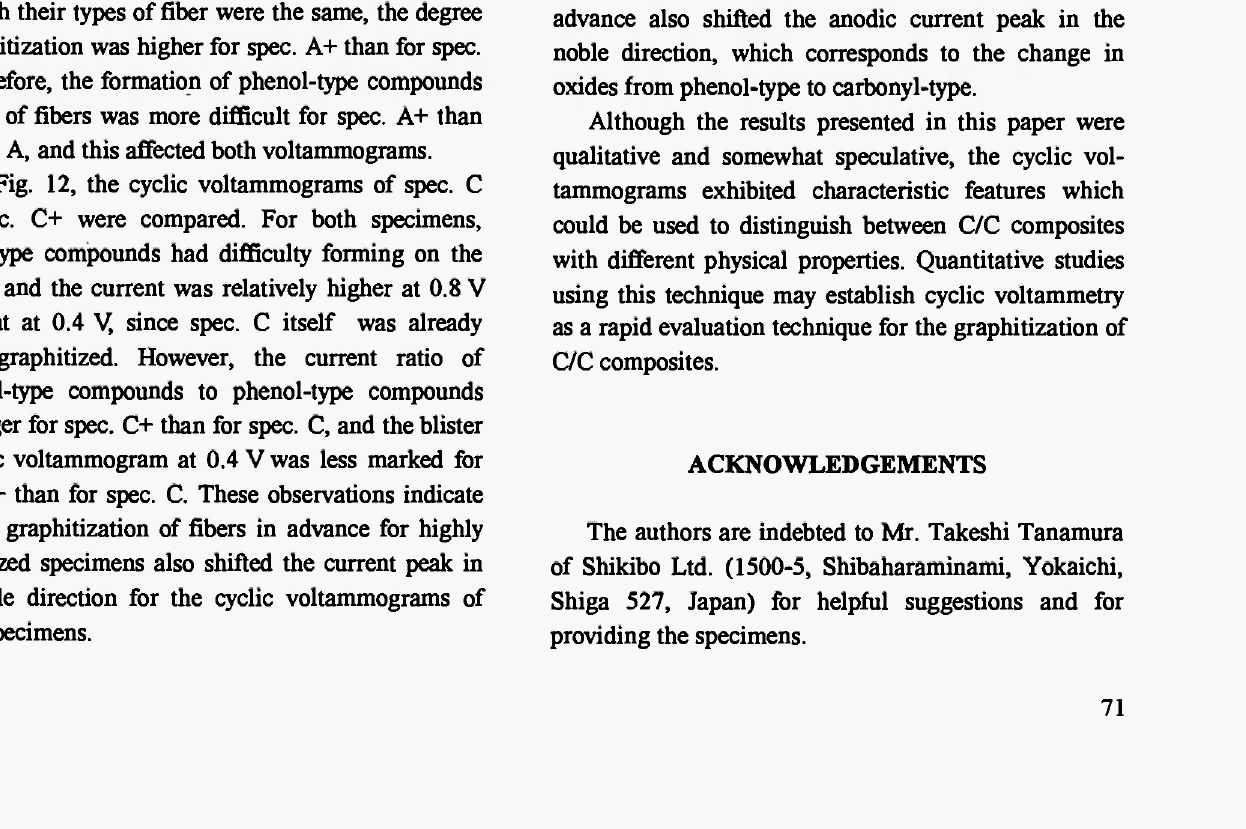
Fig. 12: Effect of HTT of the fibers on the cyclic voltammogram of spec.